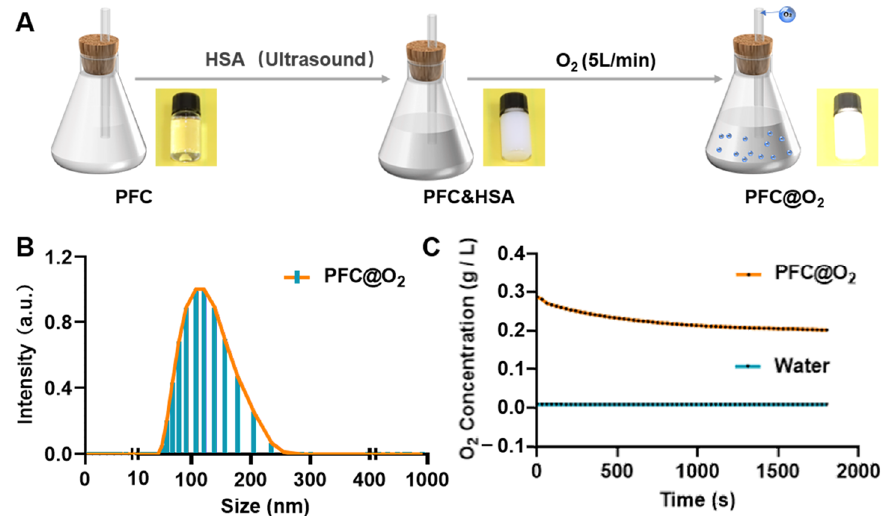
Figure 1. The preparation and characterization of PFC@O 2 . ( A ) Schematic diagram of the